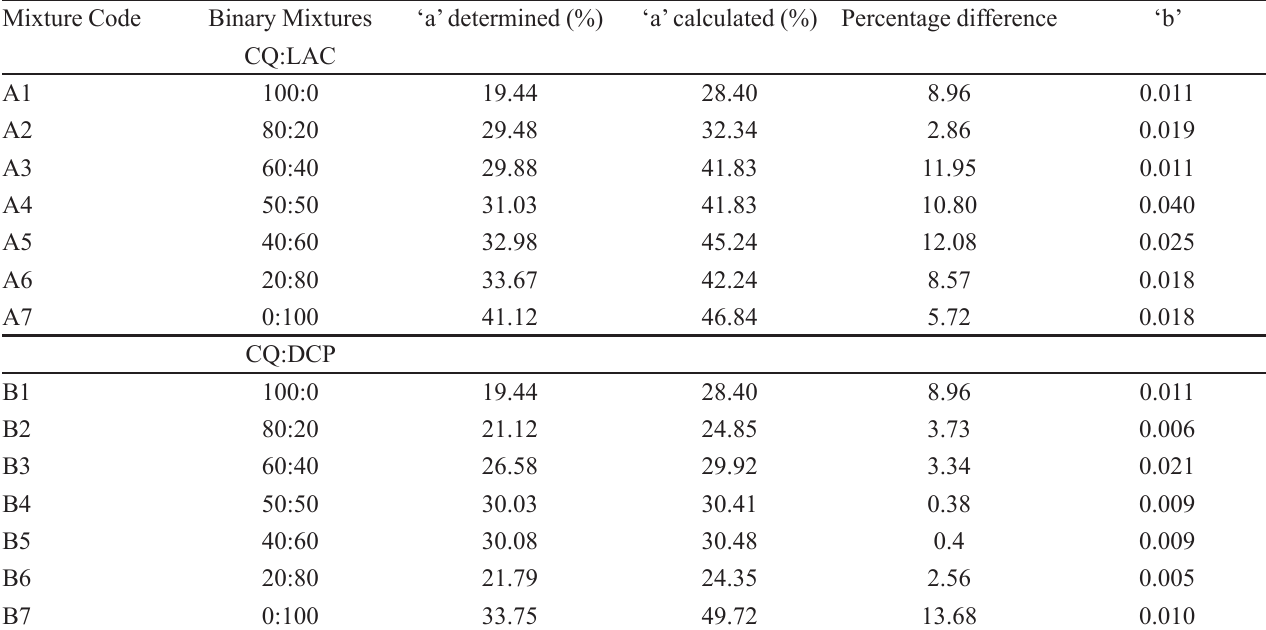
TABLE II - Percentage maximum reduction in volume due to tapping ‘a’ determined and calculated and index of compressibility ‘b’ for chloroquine/lactose (CQ:LAC) and chloroquine/dicalcium phosphate (CQ:DCP) binary mixtures Mixture